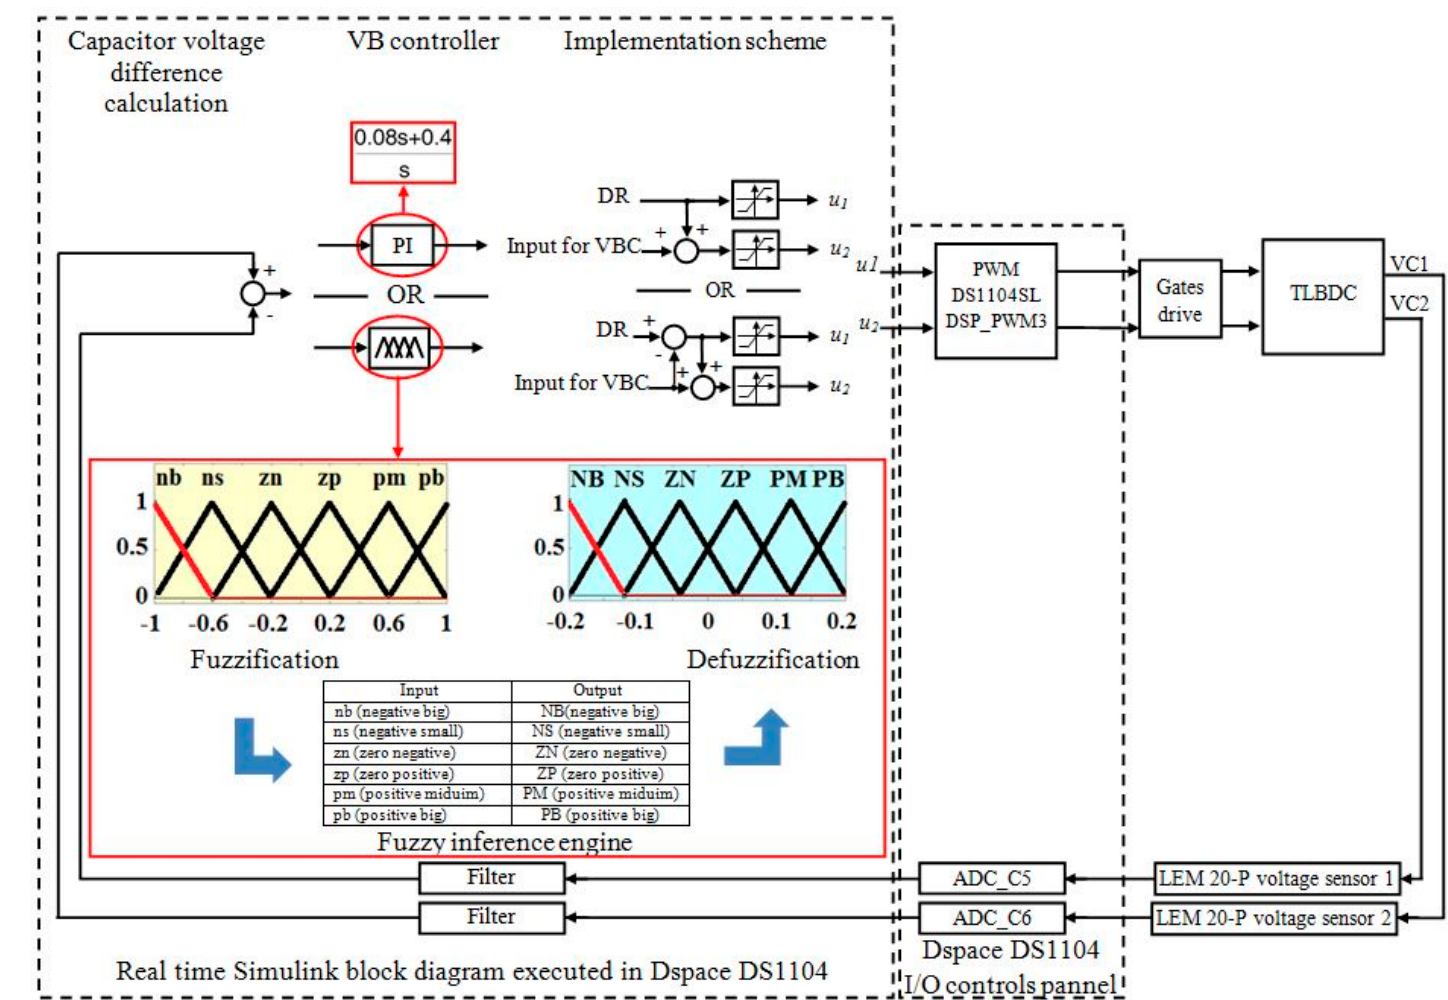
Figure 7. Block diagram of voltage balance control (VBC) schemes.